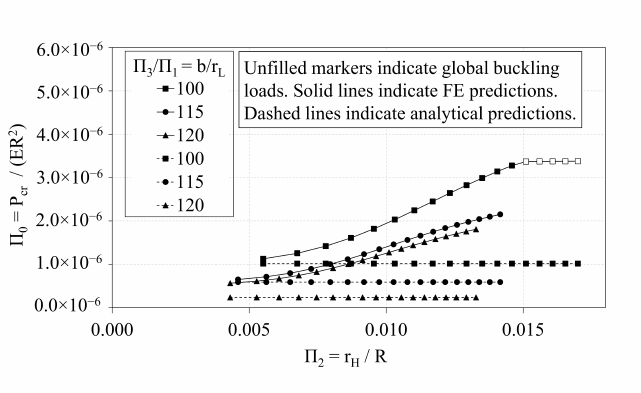
Figure 11. OLC Π 0 vs. Π 2 Analytical and FE predictions